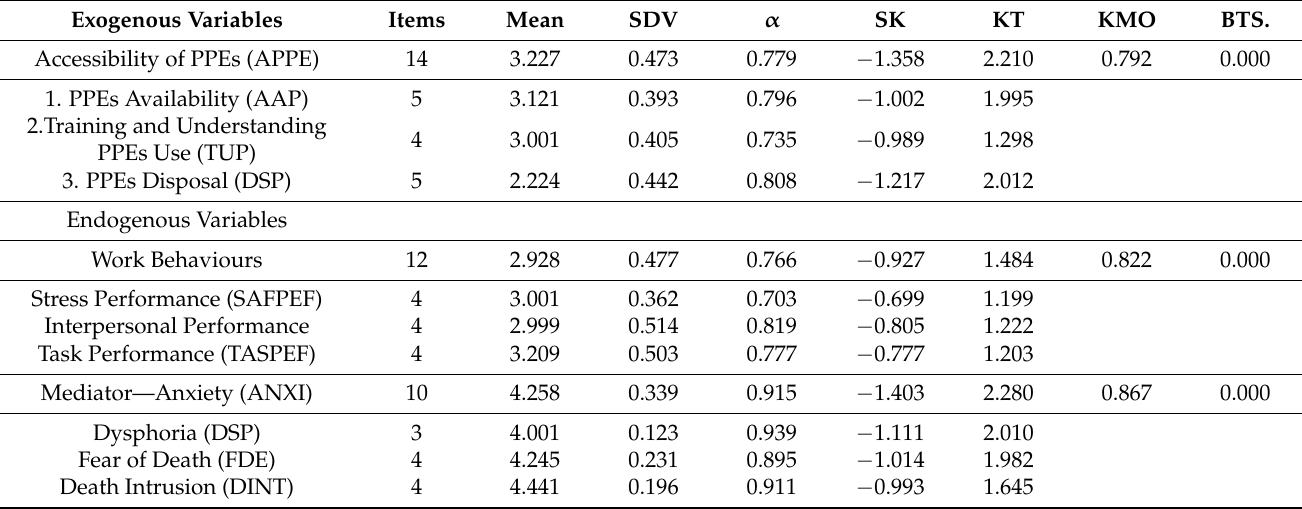
Table 2. Results for descriptive and reliability analysis.